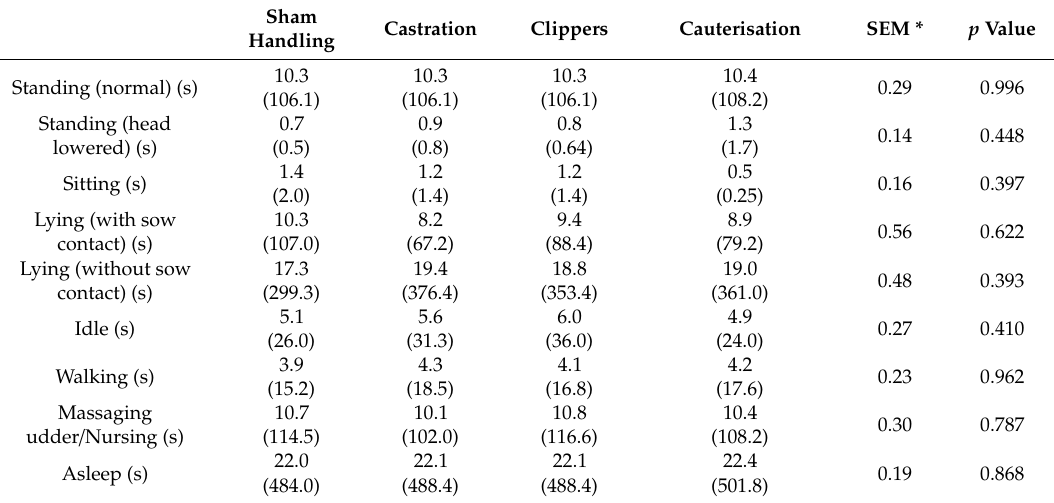
Table 4. E ff ect of treatment on behaviour of piglets for 23–24 h after treatment